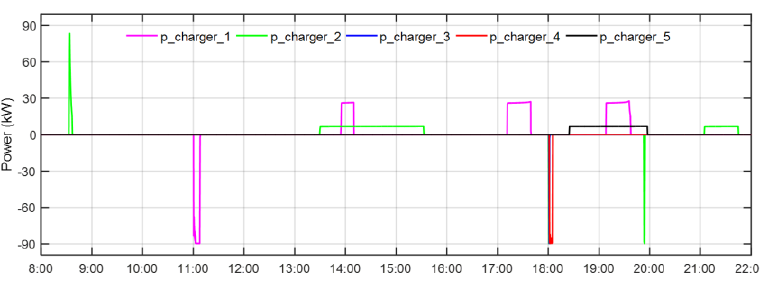
Figure 13. Power evolutions under ICDA.